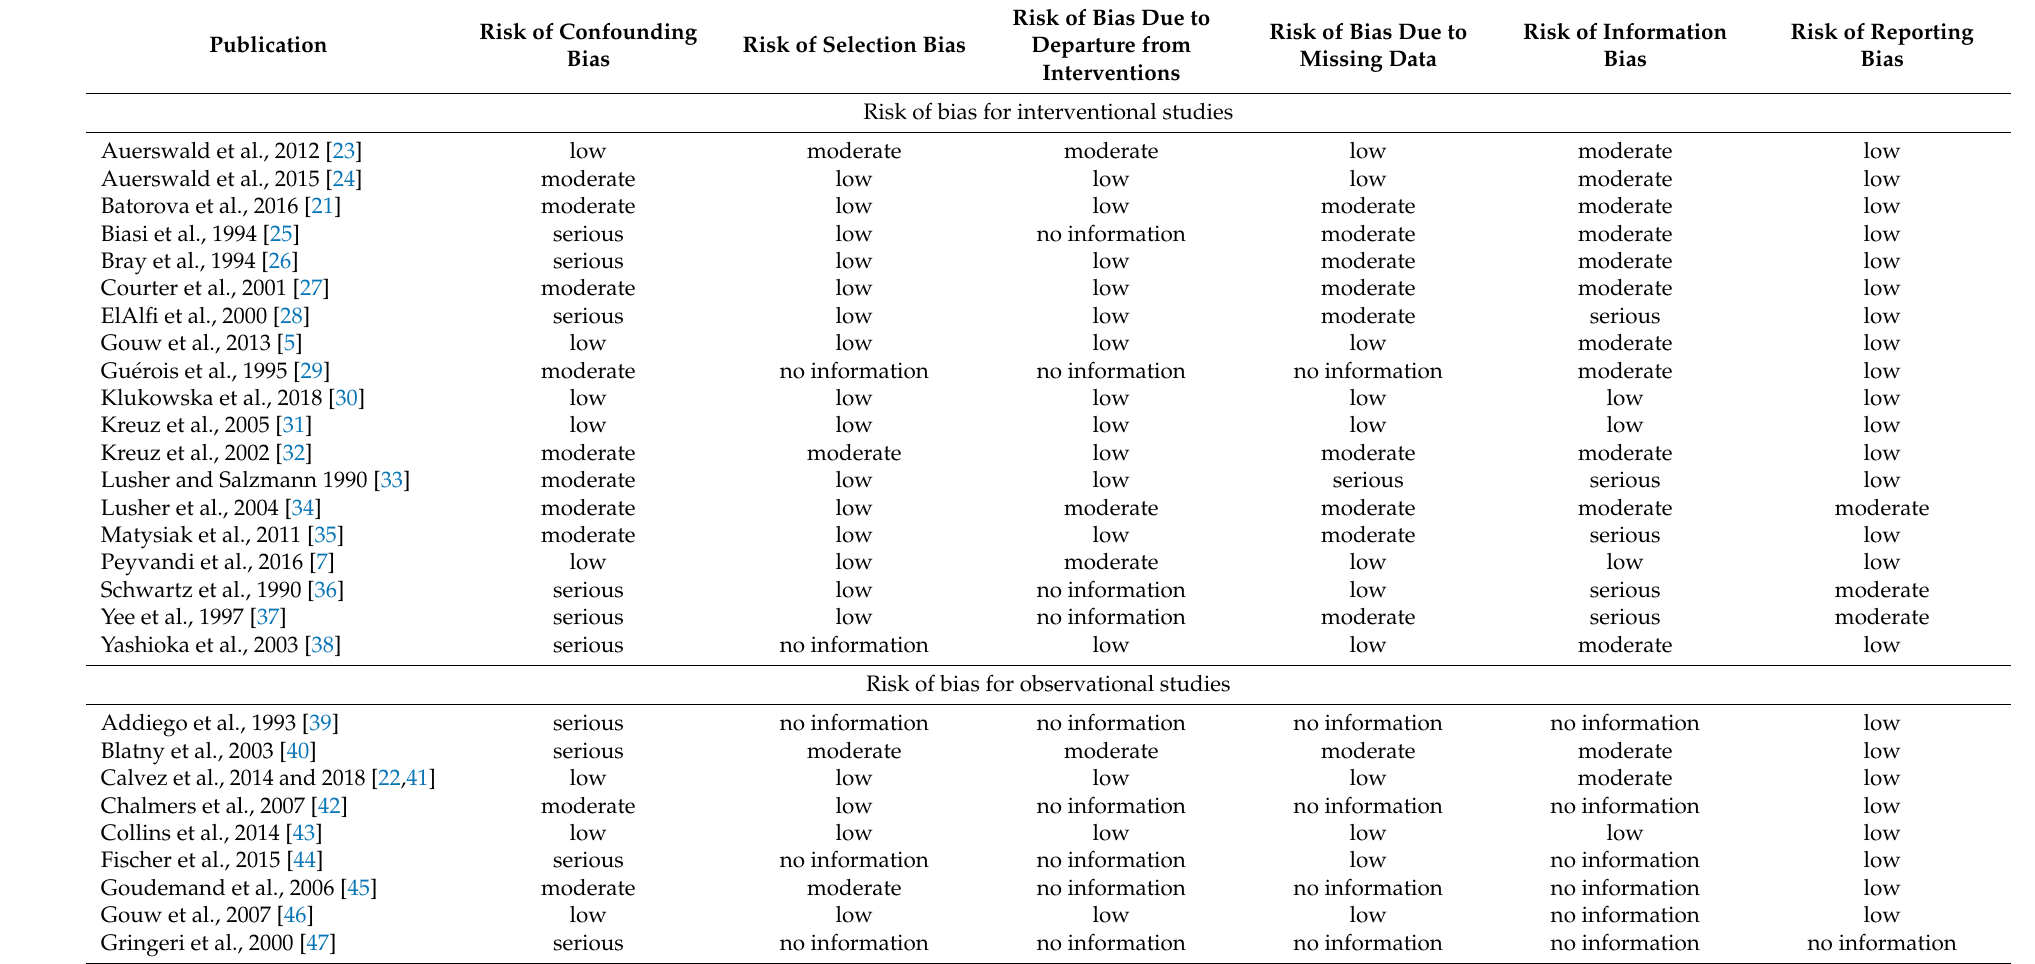
Table 1. Risk of bias in individual